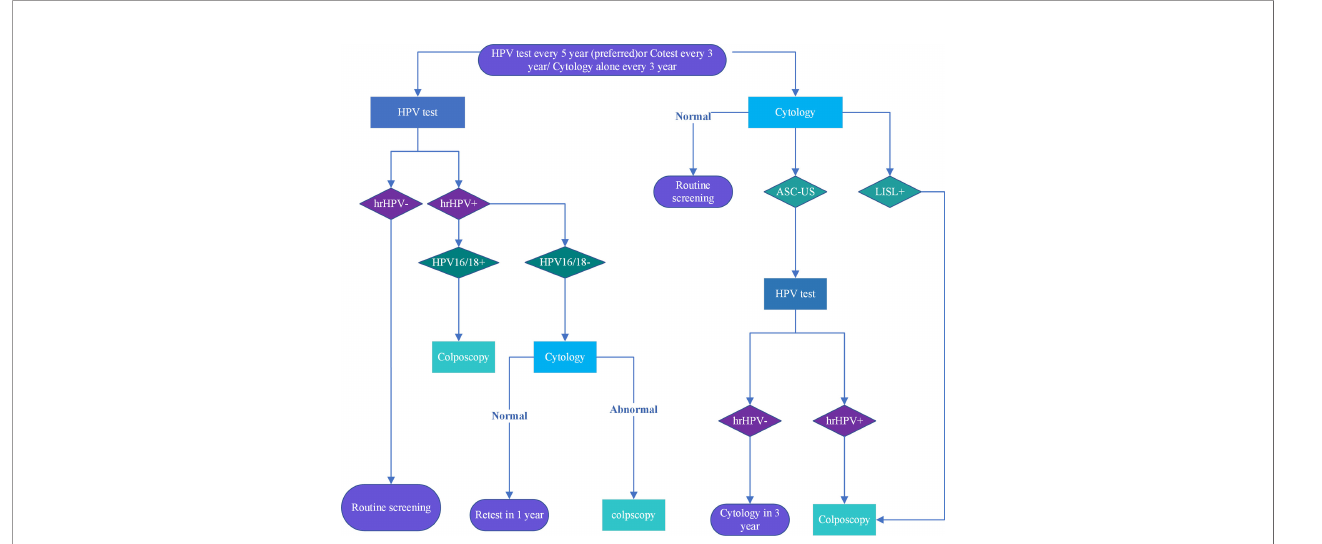
FIGURE 2 | Cervical cancer screening procedures are recommended for women aged 25 to 65. The American Cancer Society recommends screening starting at age 25 Colposcopy is recommended for HPV16/18 +, ASC-US and high risk HPV+ cytology with cytological results above ASC-H. Re-screening is recommended after 1 year for other abnormalities, and after 3 years for normal ones.